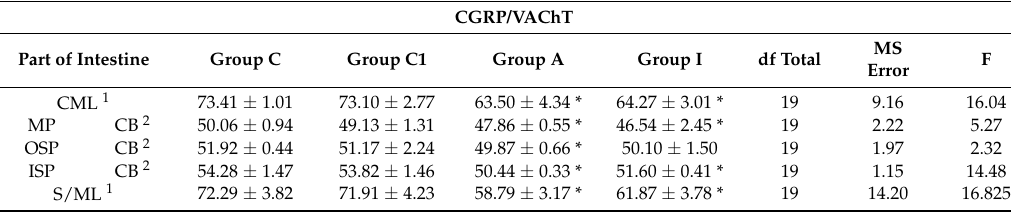
Table 3. Co-localization of CGRP with vesicular acetylcholine transporter (VAChT) in the enteric nervous structures of the porcine descending colon under physiological conditions (Group C), after “sham” operation (Group C1), after axotomy (Group A) and during inflammation (Group I).